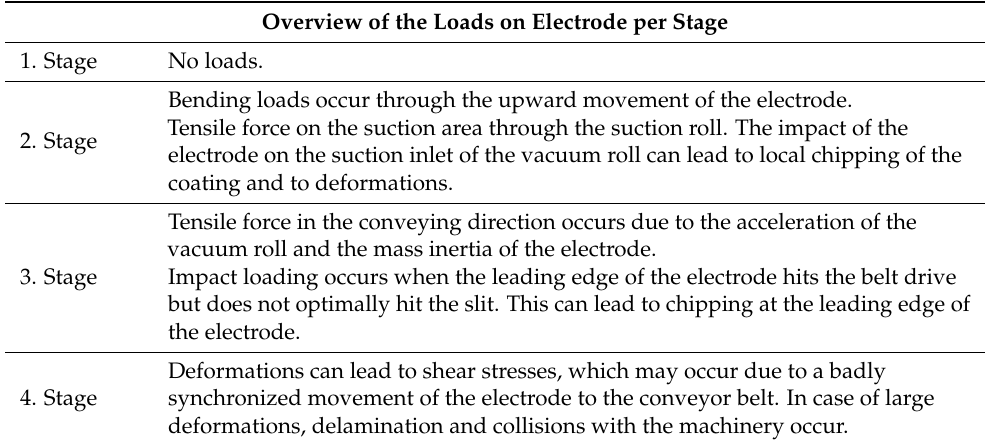
Table 1. Results of the process analysis of the separation module from the first step of the method. Overview of the Loads on Electrode per